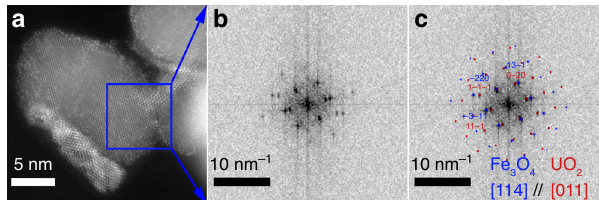
Fig. 3 Diffraction pattern of a 4-h sample. a High-angle annular dark- fi eld scanning transmission electron microscopy image for the replicate 4-h sample, showing magnetite particle and uraninite nanoparticle (Fig. 2c). b Diffraction pattern in the blue box area in a . The blue box area in a represents the magnetite grain oriented in the [114] zone axis (blue points in c ) that is parallel to UO 2 nanoparticle in the short nanowire (red points in c ) which are oriented in the [011] zone axis. Our observation shows that (-11-1) UO 2 planes align along speci fi c magnetite planes in this case (2 – 20), this gives a small lattice mismatch of 6%.